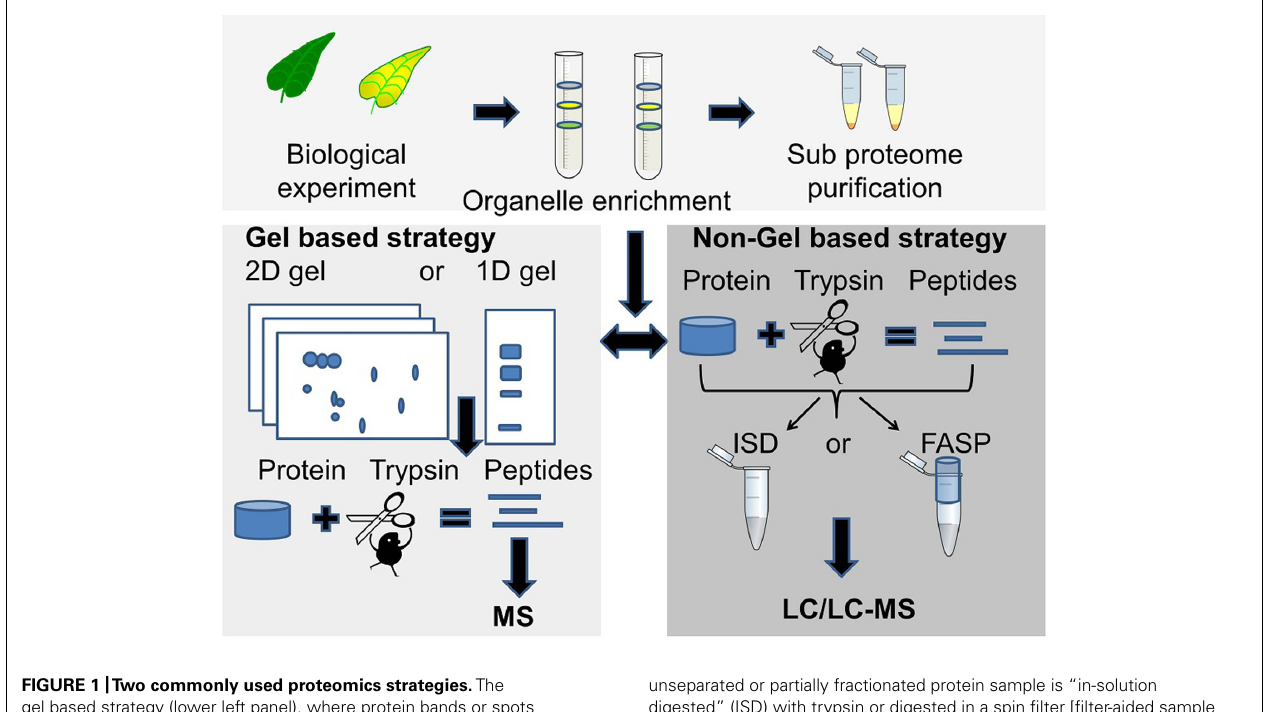
FIGURE 1 |Two commonly used proteomics strategies. The gel based strategy (lower left panel), where protein bands or spots are cut out of the gel followed by trypsin digestion and MS analysis of peptides, and the MS based strategy (lower right panel) where the